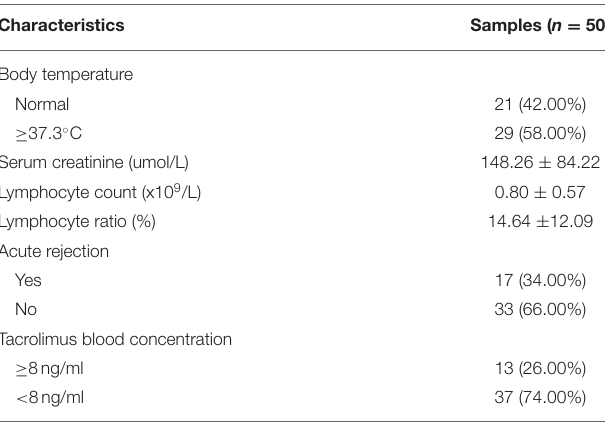
TABLE 2 | Baseline characteristics of